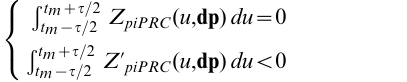
Figure 4. Adjustment error as a function of the coupling amplitude for three coupling windows. (A) In gray, RMS error when is multiplied by r from ZT22.5 to ZT6.5; in black RMSerror when d P d P T divided by r from ZT12.8 to ZT13.95 (solid), from ZT13 to ZT13.65 (dashed), and from ZT12 to ZT15.47 (dash-dotted). The shaded area correspond to adjustment RMS errors below 10%. (B) Waveform error, given by the minimal adjustment error obtained when a variable phase shift isapplied to theentrainedoscillations;(C)Phaseerror, defined asthe phase shift for which the minimal adjustment error is obtained.